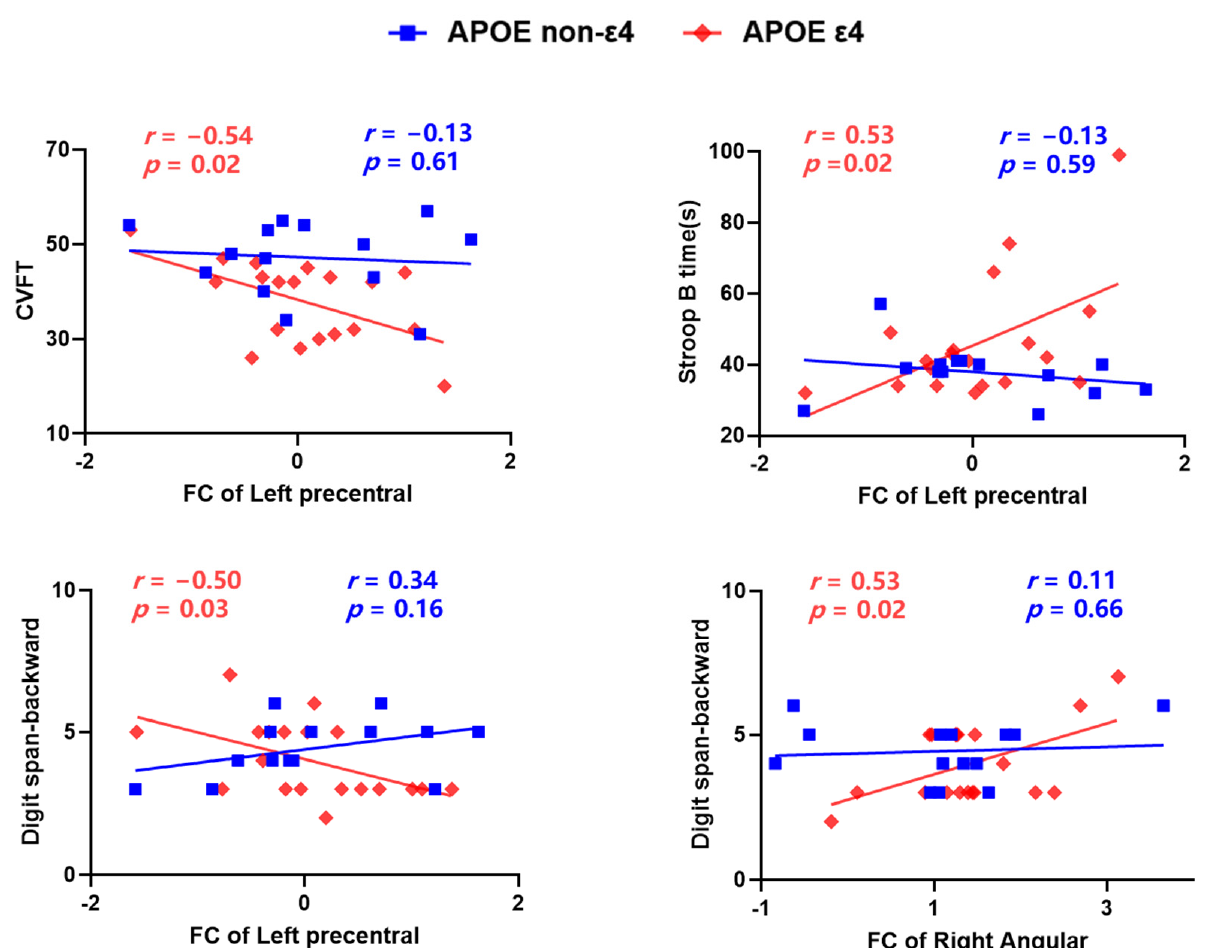
Figure 4. The relationship between functional connectivity within the frontal-parietal network and cognition. The functional connectivity (FC) of the left precentral regions is correlated with the performance of Digit span-backward, Category Verbal Fluency Test (CVFT) and the reaction times of the Stroop B test only in the ε 4-carrier group. The functional connectivity of the right angular is correlated with the performance of digit span-backward only in the ε 4-carrier group. p < 0.05, uncorrected.